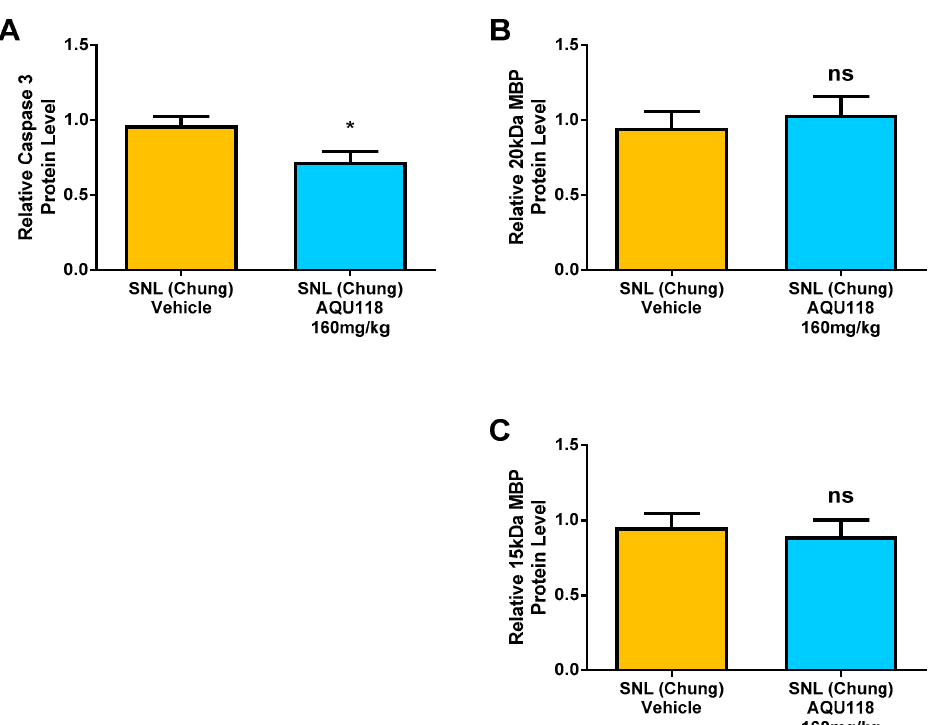
Figure 8. Comparison of caspase-3 and MBP in the ipsilateral DRG for vehicle and AQU-118 groups. ( A ) Caspase-3 protein levels in the left (ipsilateral) DRG significantly decreased in the AQU-118 group ( n = 20) compared to the vehicle ( n = 20). ( B ) There were no significant changes in MBP levels in both the upper band (20 kDa) and ( C ) lower band (15 kDa) in AQU-118 group ( n = 20) of the left (ipsilateral) DRG as compared to the vehicle group ( n = 20). Protein level is presented normalized to GAPDH and relative to the vehicle group. Data presented as the average ± SEM. An unpaired t-test was performed: ns, not significant; *, p < 0.05.